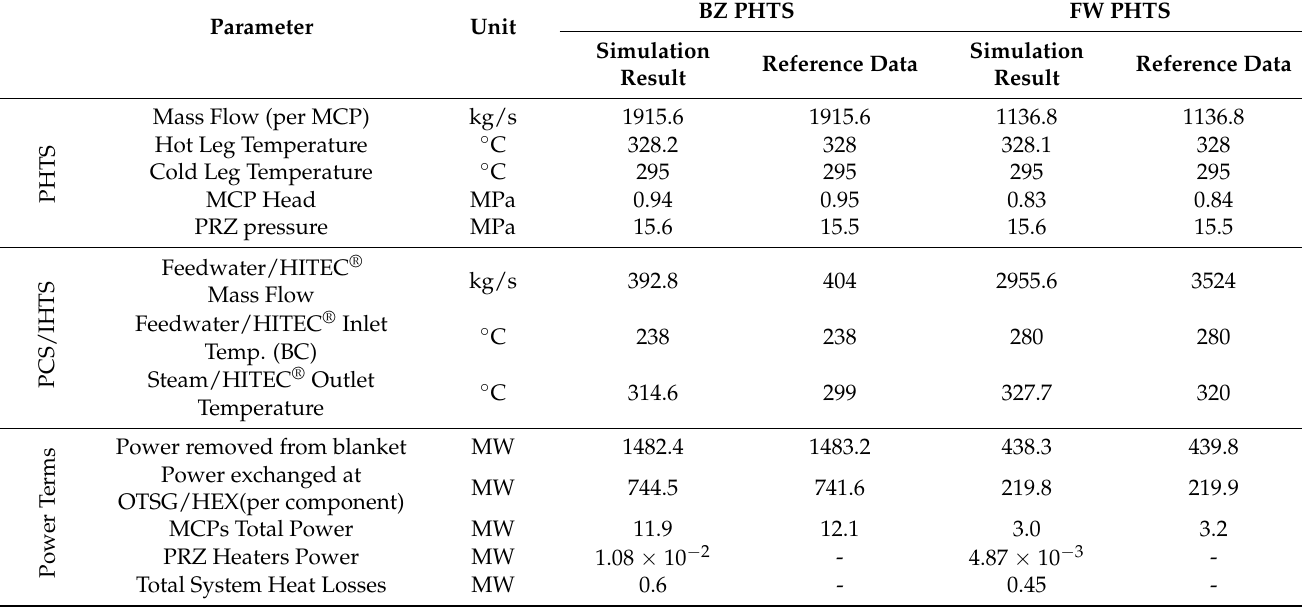
Table 4. Full plasma power state: main thermal-hydraulic parameters related to BZ and FW PHTS, Intermediate Heat Transfer System (IHTS) and PCS. Comparison between simulation results and reference data derived from